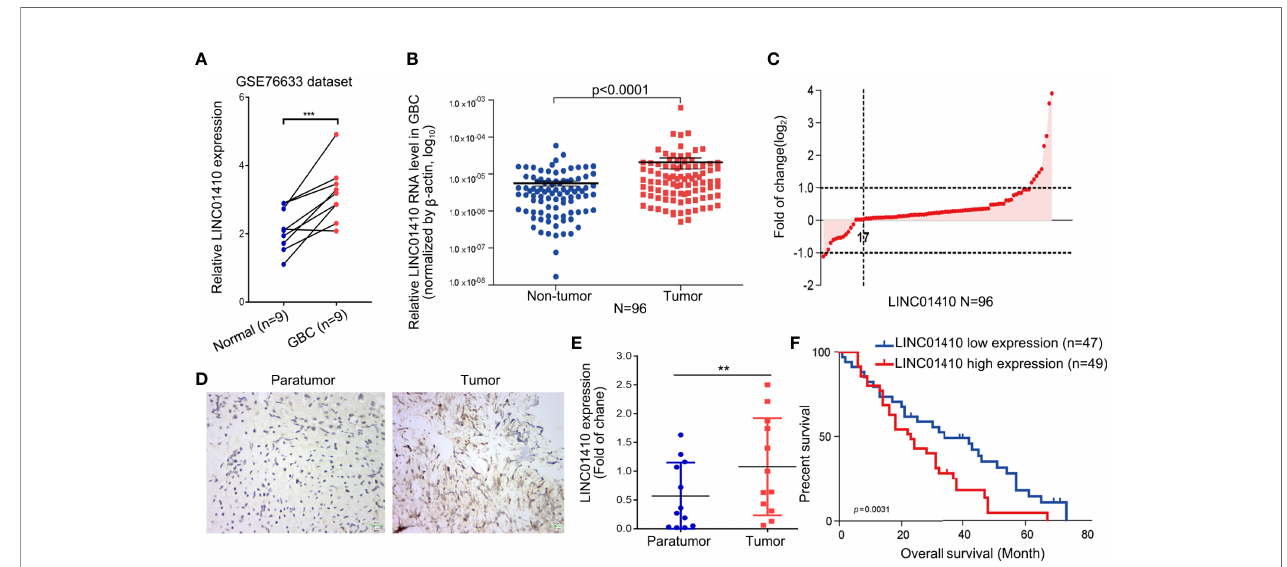
FIGURE 2 | LINC01410 was signi fi cantly upregulated in GBC tissues and cells and associated with poor prognosis. (A) LINC01410 expression levels in GBC tissues and paired non-tumor tissues in the GSE76633 dataset. ***p < 0.001. (B) LINC01410 expression in GBC tissues detected by qRT-PCR in 96 pairs of GBC tissues and paired non-tumor tissues. (C) Distribution of LINC01410 expression in 96 pairs of GBC tissues. (D) Representative images of ISH for LINC01410 expression in GBC tissues and paired non-tumor tissues. (E) ISH analysis of LINC01410 expression in the GBC tissues and paired non-tumor tissues (n = 12). **p < 0.01. (F) Kaplan – Meier analysis of the overall survival of GBC patients strati fi ed by LINC01410 expression (n = 96).